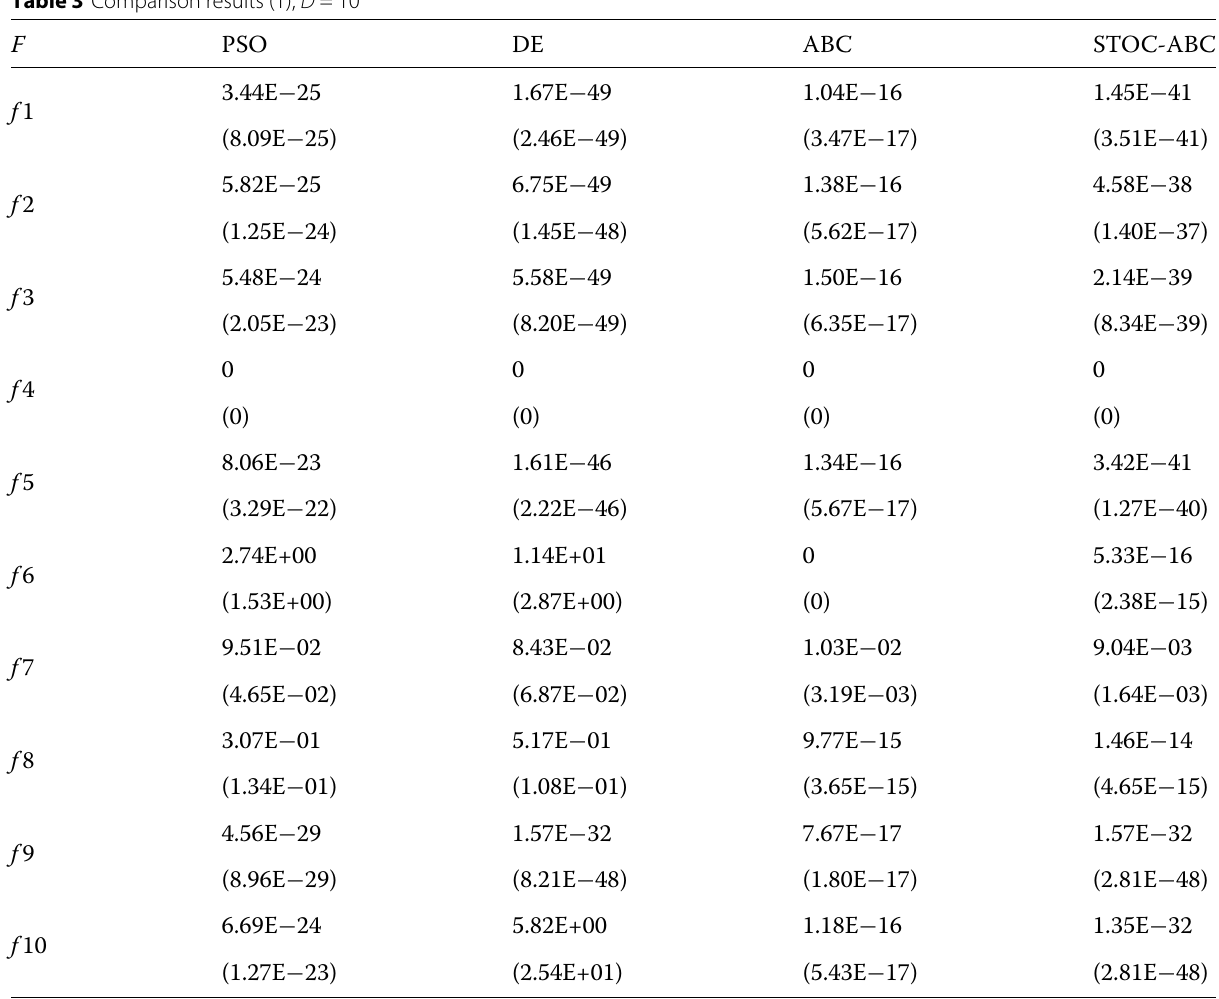
Table 3 Comparison results (1), D =